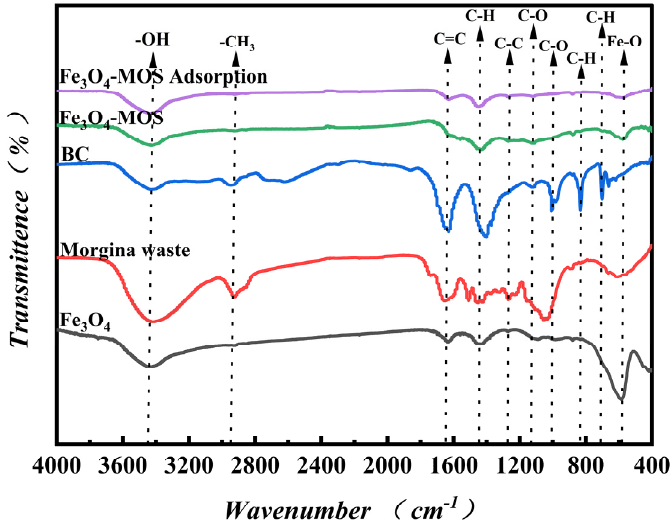
Figure 4. FT − IR spectra of magnetic Fe 3 O 4 nanoparticles, Moringa waste, BC, Fe 3 O 4 − MOS and Fe 3 O 4 - Figure 4. FT–IR spectra of magnetic Fe 3 O 4 nanoparticles, Moringa waste, BC, Fe 3 O 4 -MOS and MOS adsorption. Fe 3 O 4 -MOS